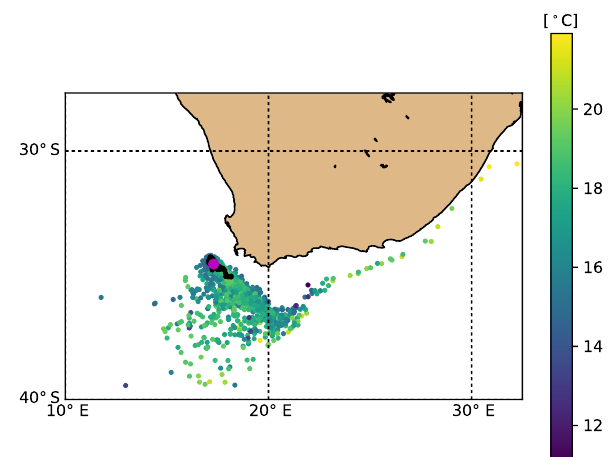
Figure 3. Footprints of virtual foraminifera ending up on the ocean floor just off Cape Town in the Agulhas region. This experiment is a Parcels implementation of the study described in Van Sebille et al. (2015), and this figure can be compared to Fig. 1b in that paper. The magenta dot is the location of the sediment core, from which virtual particles are first tracked back until they reach their 50m dwelling depth (black dots), and then further tracked back for their 30-day lifespan. Temperatures (in Celsius) are recorded each day throughout their lifespan and shown as colours. The code for this experiment and plotting is available at https://doi.org/10.5281/